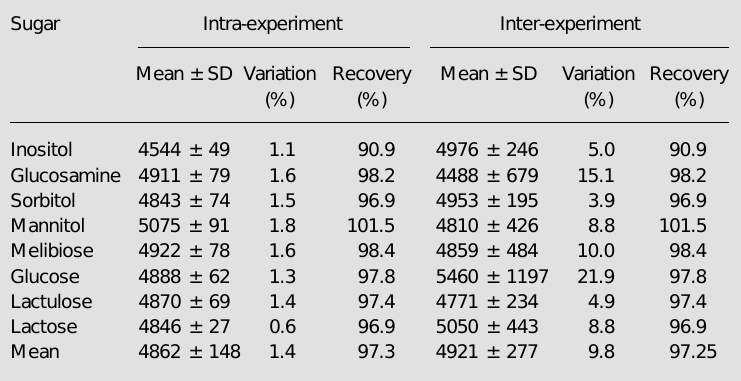
Table 1 - Intra- and inter-experiment variation and recovery of standard sugars meas- ured by HPLC and pulsed amperometric detection. The data are reported as means ± SD of recovered picomoles of each sugar. Sugar